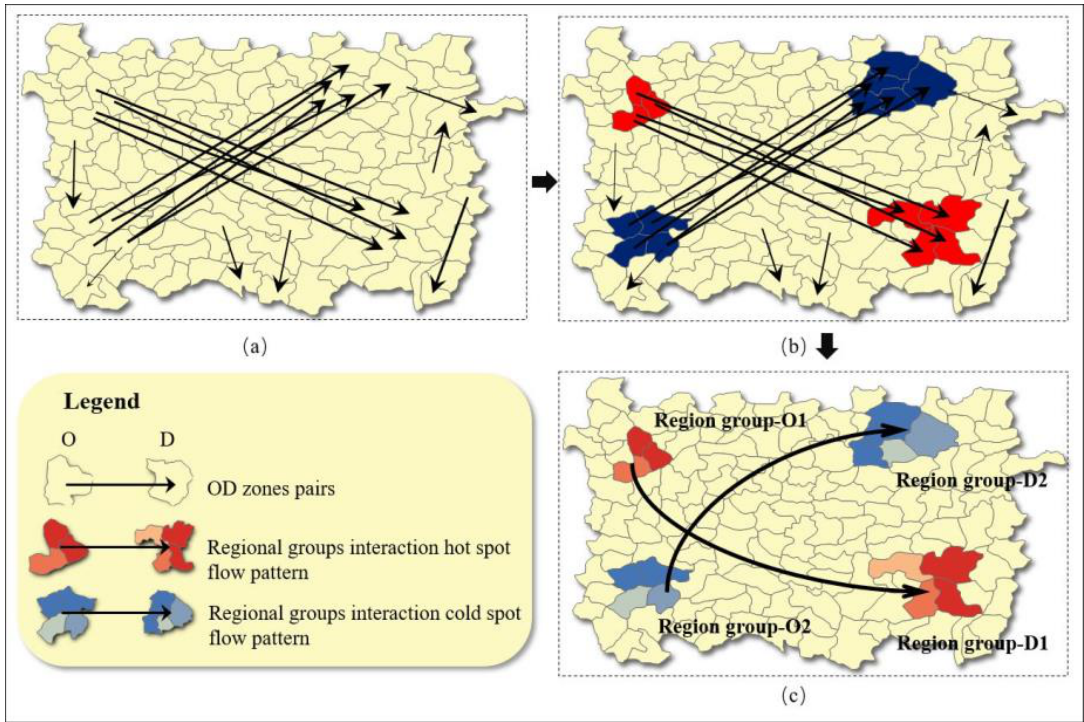
Figure 3. Flow pattern and visualization of interaction hotspots between regional groups. ( a ) Area-to-area flow data; ( b ) area-to-area flow data and area pairs with high interaction values; and ( c ) similar hotspot flow patterns between regional groups.